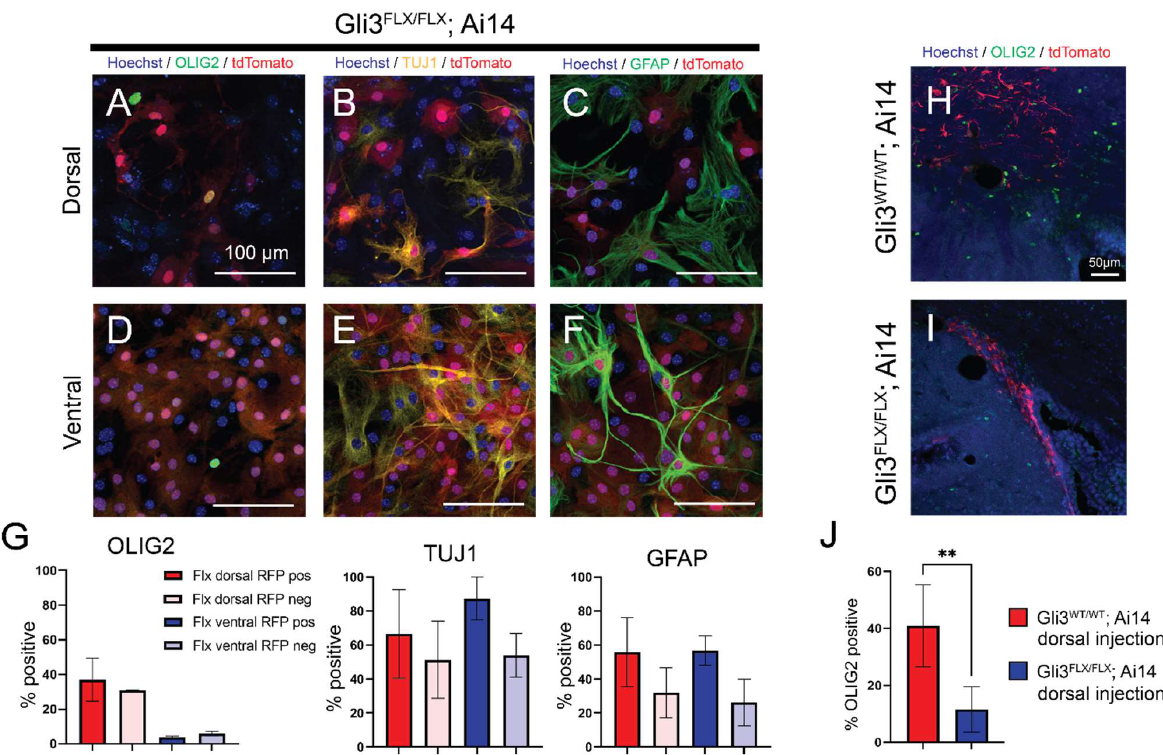
Figure 4. In vitro differentiation is not altered upon ablation of GLI3 in cultured V-SVZ progenitors, but in vivo oligodendrogenesis is altered in adults. Cultures derived from Gli3 FLX/FLX ; Ai14 animals were grown in standard neural stem cell proliferation media and transduced with Ad:CMVp-Cre prior to removal of growth factors and induction of differentiation. After 21 days, cultures were analyzed for the expression of OLIG2 ( A , D ), TUJ1 ( B , E ), and GFAP ( C , F ). Quantification of labeling for each marker in RFP-positive and RFP-negative cells from Gli3 FLX/FLX ; Ai14 cultures is shown in ( G ). Bars represent mean +/− SEM across 3 independent replicates. D/V = dorsal or ventral region. To test the effects of GLI3 ablation in vivo, adult (P30–P40) animals were injected with Ad:GFAPp- Cre and labeled progeny were assessed at 30 days post injection for OLIG2 expression ( H , I ). The fraction of RFP-labeled progeny expressing OLIG2 was significantly decreased in Gli3 FLX/FLX ; Ai14 animals ( J ). Bar charts represent mean +/− SEM across 3 ( Ai14 ) or 5 ( Gli3 FLX/FLX ; Ai14 ) independent biological replicates. ** p = 0.0089, unpaired t- test. 4. Conclusions How and when positional identity is first encoded in the cells of the V-SVZ remains an active area of investigation, as well as the mechanisms that lead to neuronal and glial lineage generation in different subdomains throughout life. SHH signaling, and specific downstream pathway members, have been implicated in identity specification, stem cell quiescence, and persistence of stem cells during postnatal life [13,19,34]. Pathway inhibi- tion, via generation of GLI3R, is a key step in regulation of this signaling; although, acti- vation by GLI3A has also been suggested to be required in the regional specification of brain structures such as the hypothalamus [35]. The higher abundance of GLI3R protein in the cells of the dorsal V-SVZ suggests that these NSCs may have a higher threshold for activation of SHH signaling, consistent with prior experiments in which short term ad- ministration of SHH ligand or SAG in vivo or ex vivo was not sufficient to increase Gli1 - driven reporter expression [16]. Ablation of the canonical coreceptor SMO within the cells of the V-SVZ results in unattenuated GLI2/3 repressor forms, and thus inhibition of SHH signaling. Prior studies of SMO ablation throughout the V-SVZ found a substantial decrease in the number of